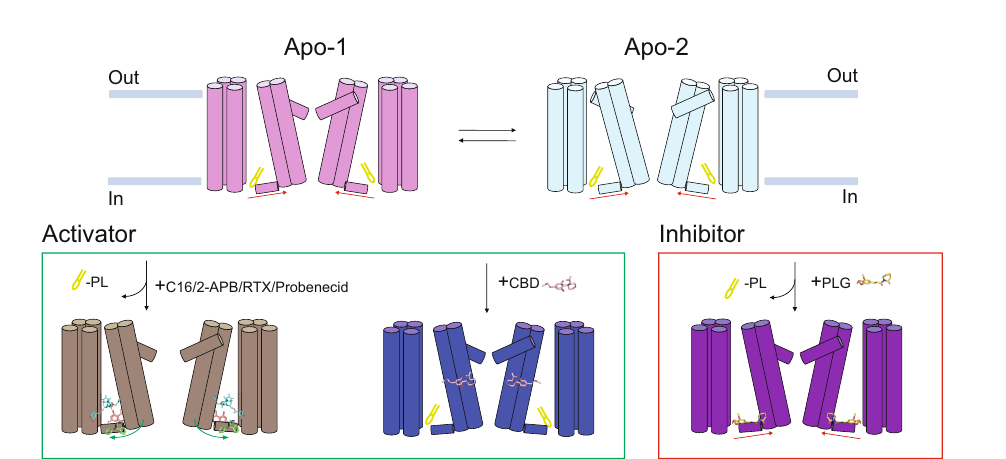
either TRPV2 probenecid or TRPV2 C16-2 structures based on global structural align- ments. Membrane views of subunits of the vanilloid pocket (left) and S5-PH-S6 domain (right) are shown (PH designate pore helix). Arrows indicate structural movementsofTRPV2 C16+pro-2 inrelationtoeitherTRPV2 probenecid orTRPV2 C16-2 .The bluemeshindicatescryo-EMdensitythatmayrelatetoC16.Residuesofinterestare shown as sticks. Local conformational changes are highlighted with stars.